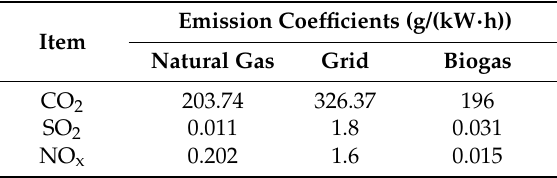
Table 6. Pollutant emission